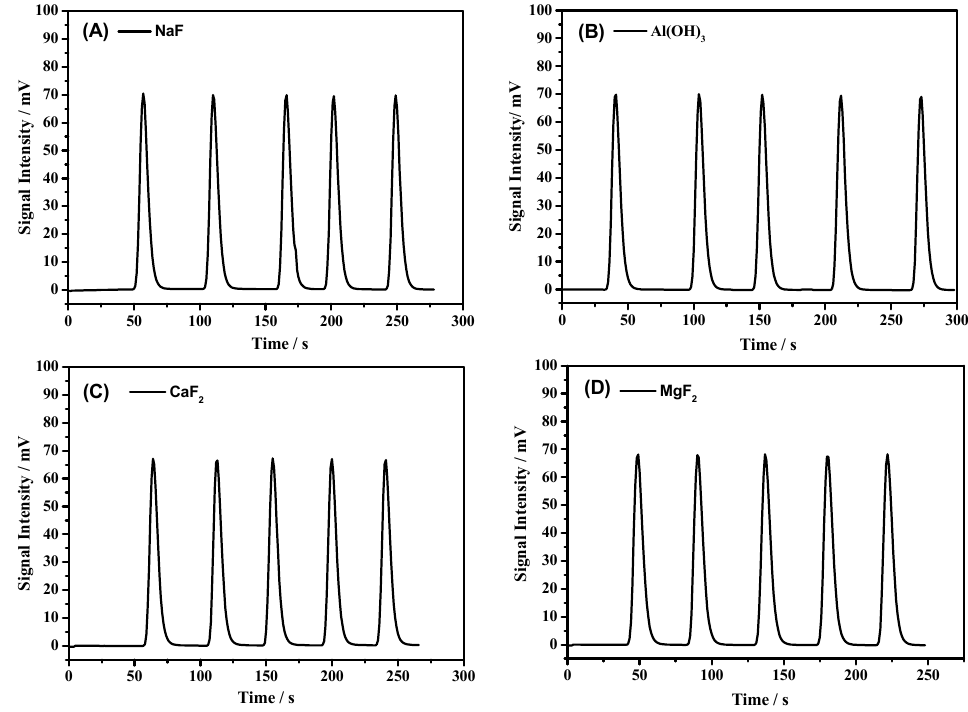
Figure 8. Adsorption performance of HF adsorbents on CO 2 , ( A ) NaF, ( B ) CaF 2 , ( C ) MgF 2 , ( D ) Al(OH) 3 .